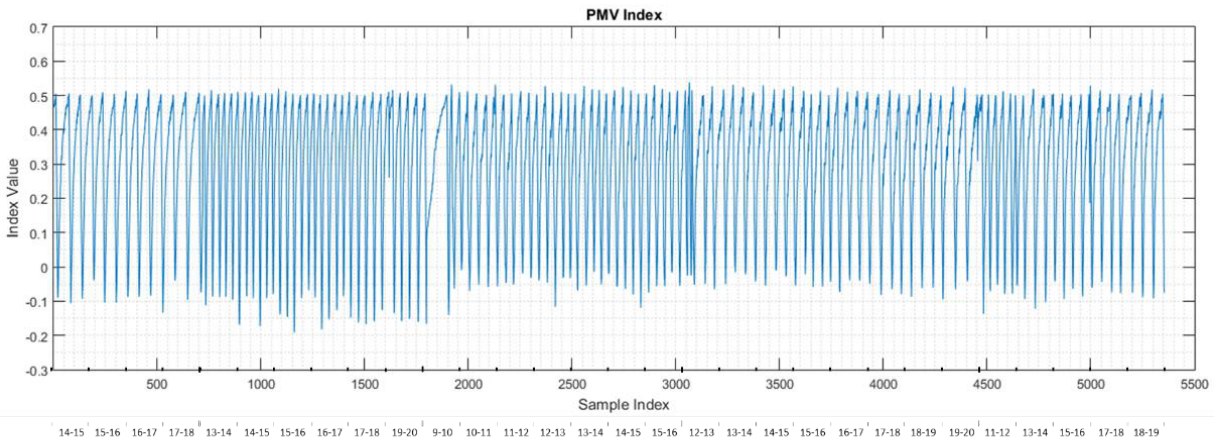
Figure 14. PMV index behavior.